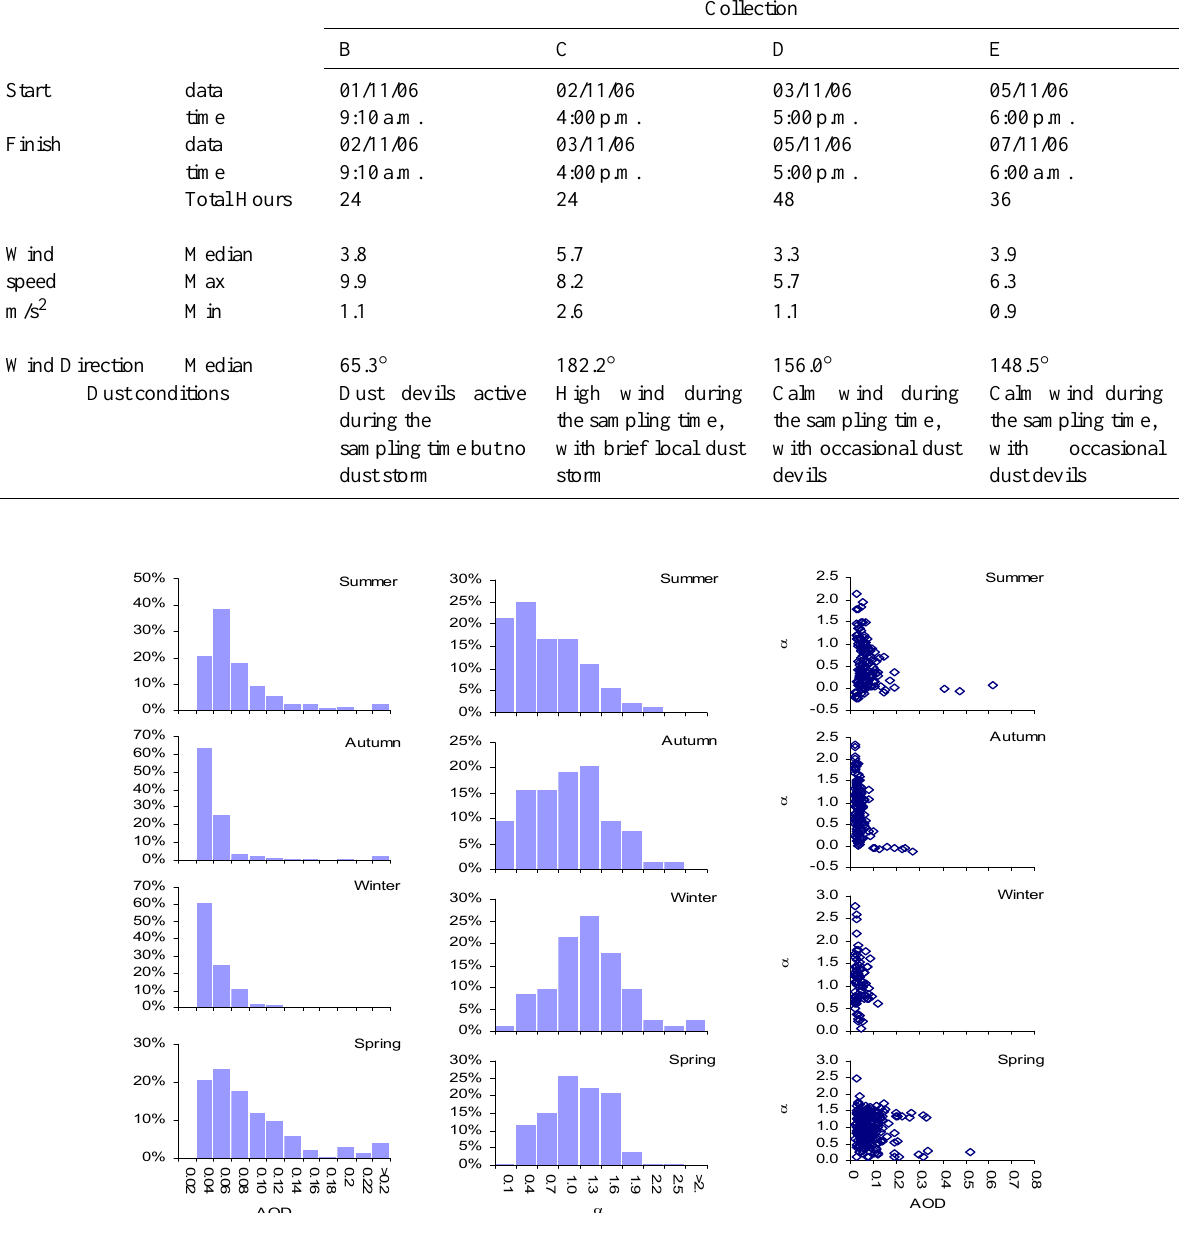
Fig. 5. Left panel: Seasonal frequency distributions of daily mean AOD. Central panel: Seasonal frequency distributions of daily mean α . Right panel: Seasonal scatter plots of daily mean α vs. daily mean